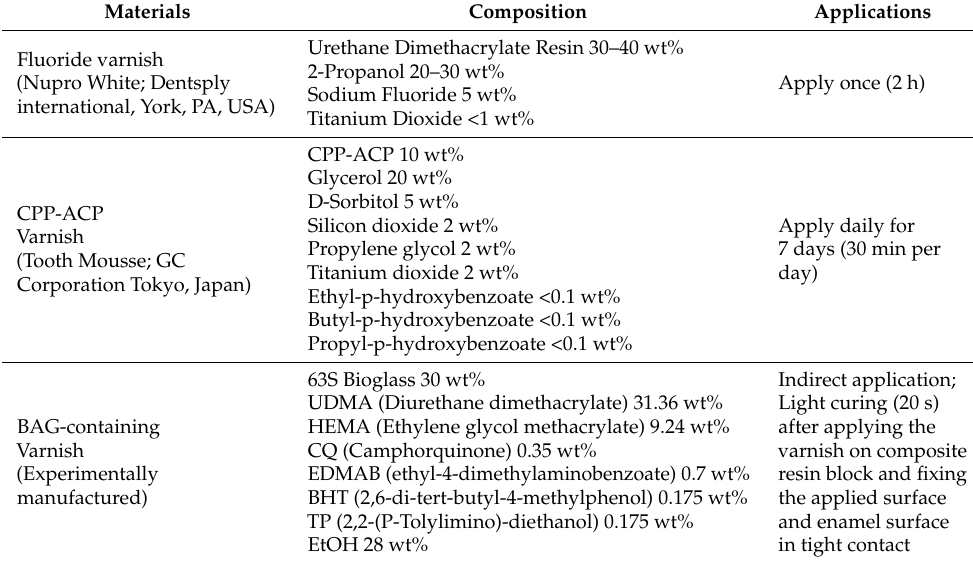
Table 1. List of varnishes used in this